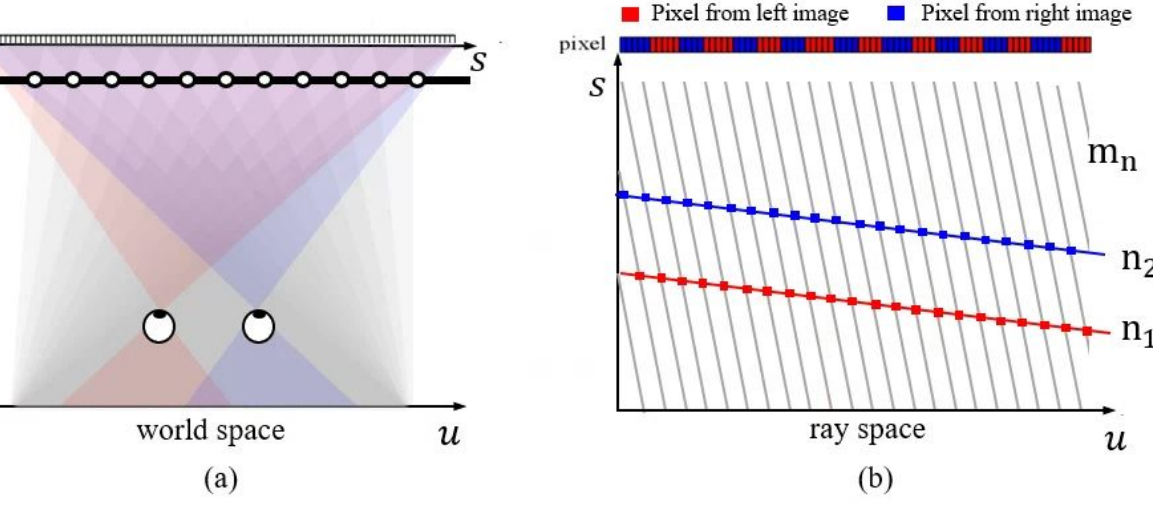
Figure 4. A horizontal 2D slice of light field in the 3D display. ( a ) Real-world setting, ( b ) equivalent representation in the ray space. Greyscale lines represent light rays passing through slits (lens), red and blue lines represent light rays passing through the left and right eye respectively. Square boxes are intersected points.